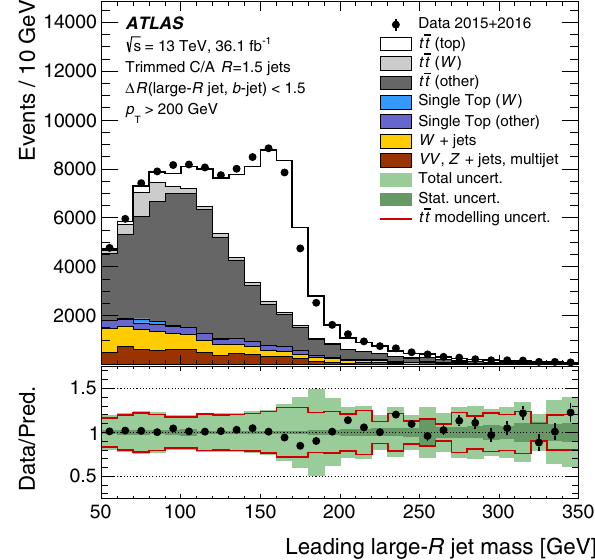
Fig. 10 A comparison of the observed data and predicted MC distri- butions of the mass of the leading p T C/A R = 1.5 trimmed jet in events passing the top-quark selection in a sample enriched in lepton+jets t ¯ t events. Simulated distributions are normalised to data. The t ¯ t sample is dividedintoasetofsubsamples(e.g. t ¯ t (top))basedoncriteriadescribed in Sect. 4.2. The statistical uncertainty of the background prediction (Stat. uncert.) results from limited Monte Carlo statistics as well as the limited size of the data sample used in the data-driven estimation of the multijet